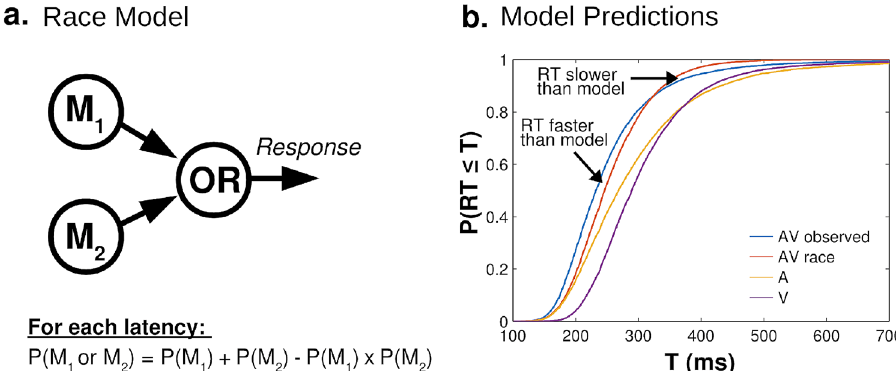
Figure 1. The race model of multisensory reaction times. ( a ) Schematic diagram of the race model architecture. Independent channels for each sensory modality (M 1 and M 2 ) feed into an OR operator which triggers responses. This results in the faster of the two channels triggering a response on any given trial. Assuming no correlation between channels, the race model predicts the probability of a response at some time T or sooner using the statistical definition of the OR operator (see equation). ( b ) Race model estimates (red) and empirical RT distribution (blue) for audiovisual (“AV”) trials in the current dataset. The race model estimate for each time bin is estimated using the cumulative reaction time distributions for unisensory auditory (“A”, yellow) and visual (“V”, purple) trials. The race model underestimates the probability of faster trials, indicating that the fastest RTs (left tail) outpace the race the model. However, the race model also overestimates the probability of slower trials, indicating that the slowest RTs (right tail) are slower than race model